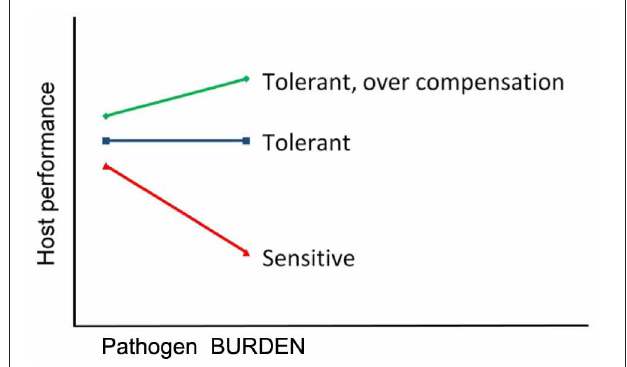
FIGURE 1 | Tolerance to infections. Tolerance is the reaction norm slope of host performance regressed against individual’s pathogen burden. The lines represent performance of three genotypes with a different degree of